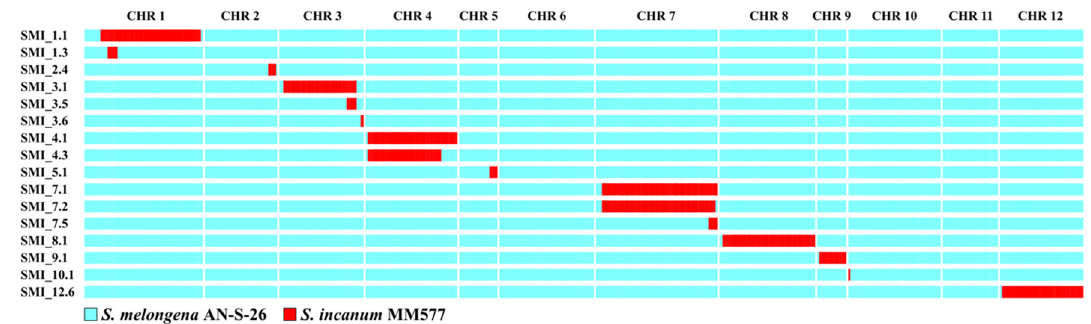
Figure 1. Graphical genotypes of the selected introgression lines (ILs) for QTLs identification: The rows indicate IL codes, and the columns indicate the chromosomes. Homozygous introgressions of S. incanum MM577 are depicted in red, while the genetic background of the recipient parent ( S. melongena AN-S-26) is depicted in blue. Table 1. Statistics of the 16 selected S. incanum (MM577) ILs in the genetic background of S. melongena (AN-S-26) calculated using the physical distance of the chromosome-anchored reference genome